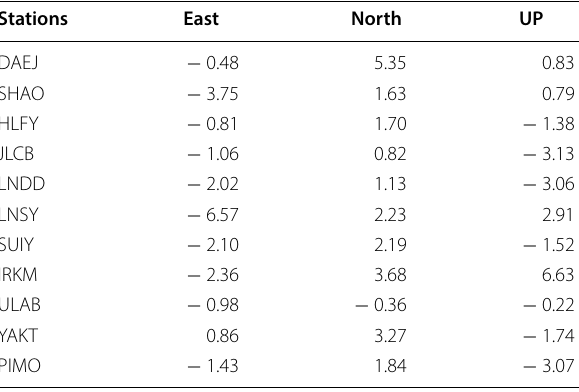
Table 3 PPP displacements (units: mm) within 1 s for the GNSS stations to the west of